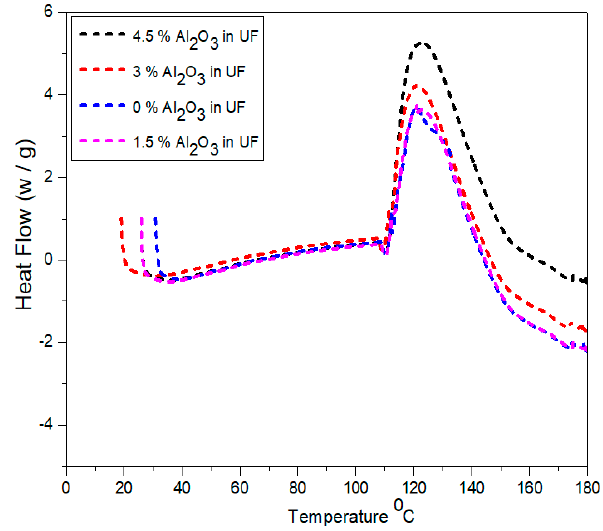
Figure 9. Differential scan calorimetry of urea-formaldehyde resin with different concentrations of alumina nanoparticles.